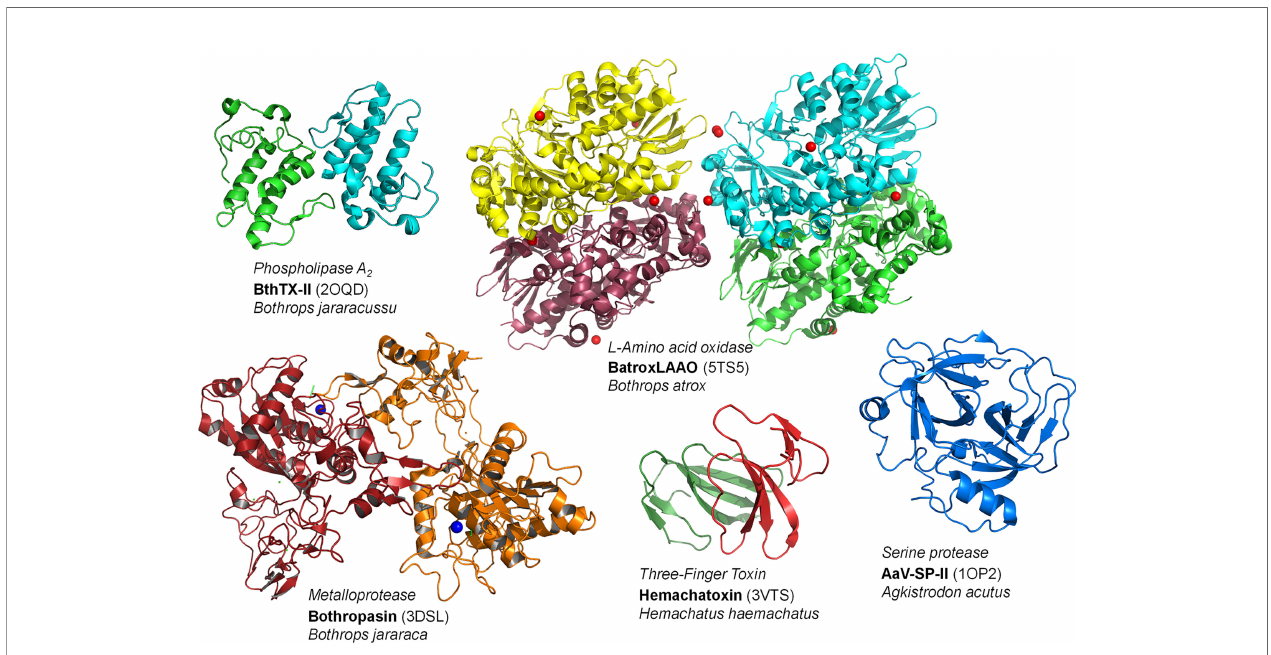
FIGURE 3 | Structures of representatives of the main toxin classes in snake venoms. Codes inside parentheses denote the PDB codes of the crustal strucutures of these proteins. The fi nal fi gure was prepared using Pymol v.